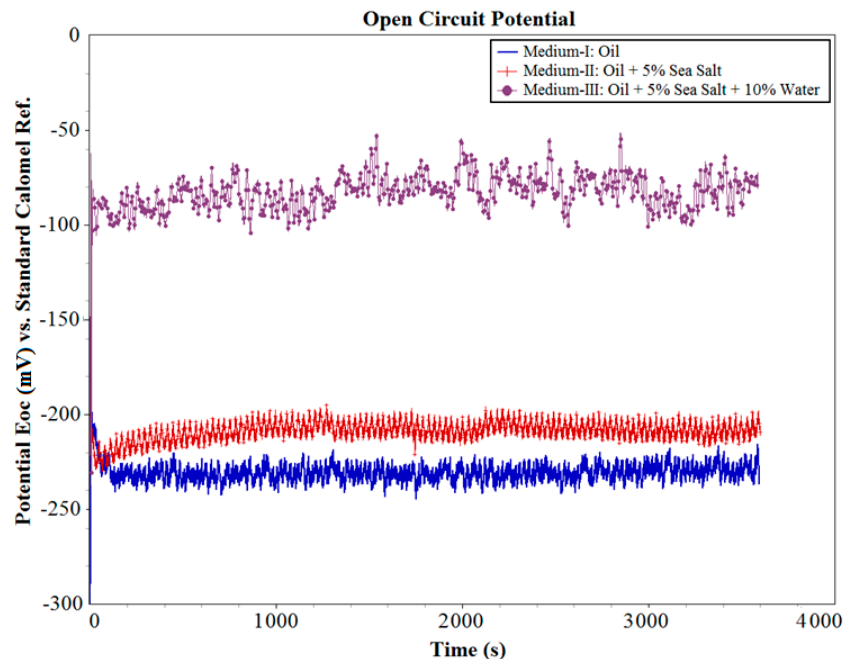
Figure 4. Open circuit potential (OCP) of sample in different oil mediums.